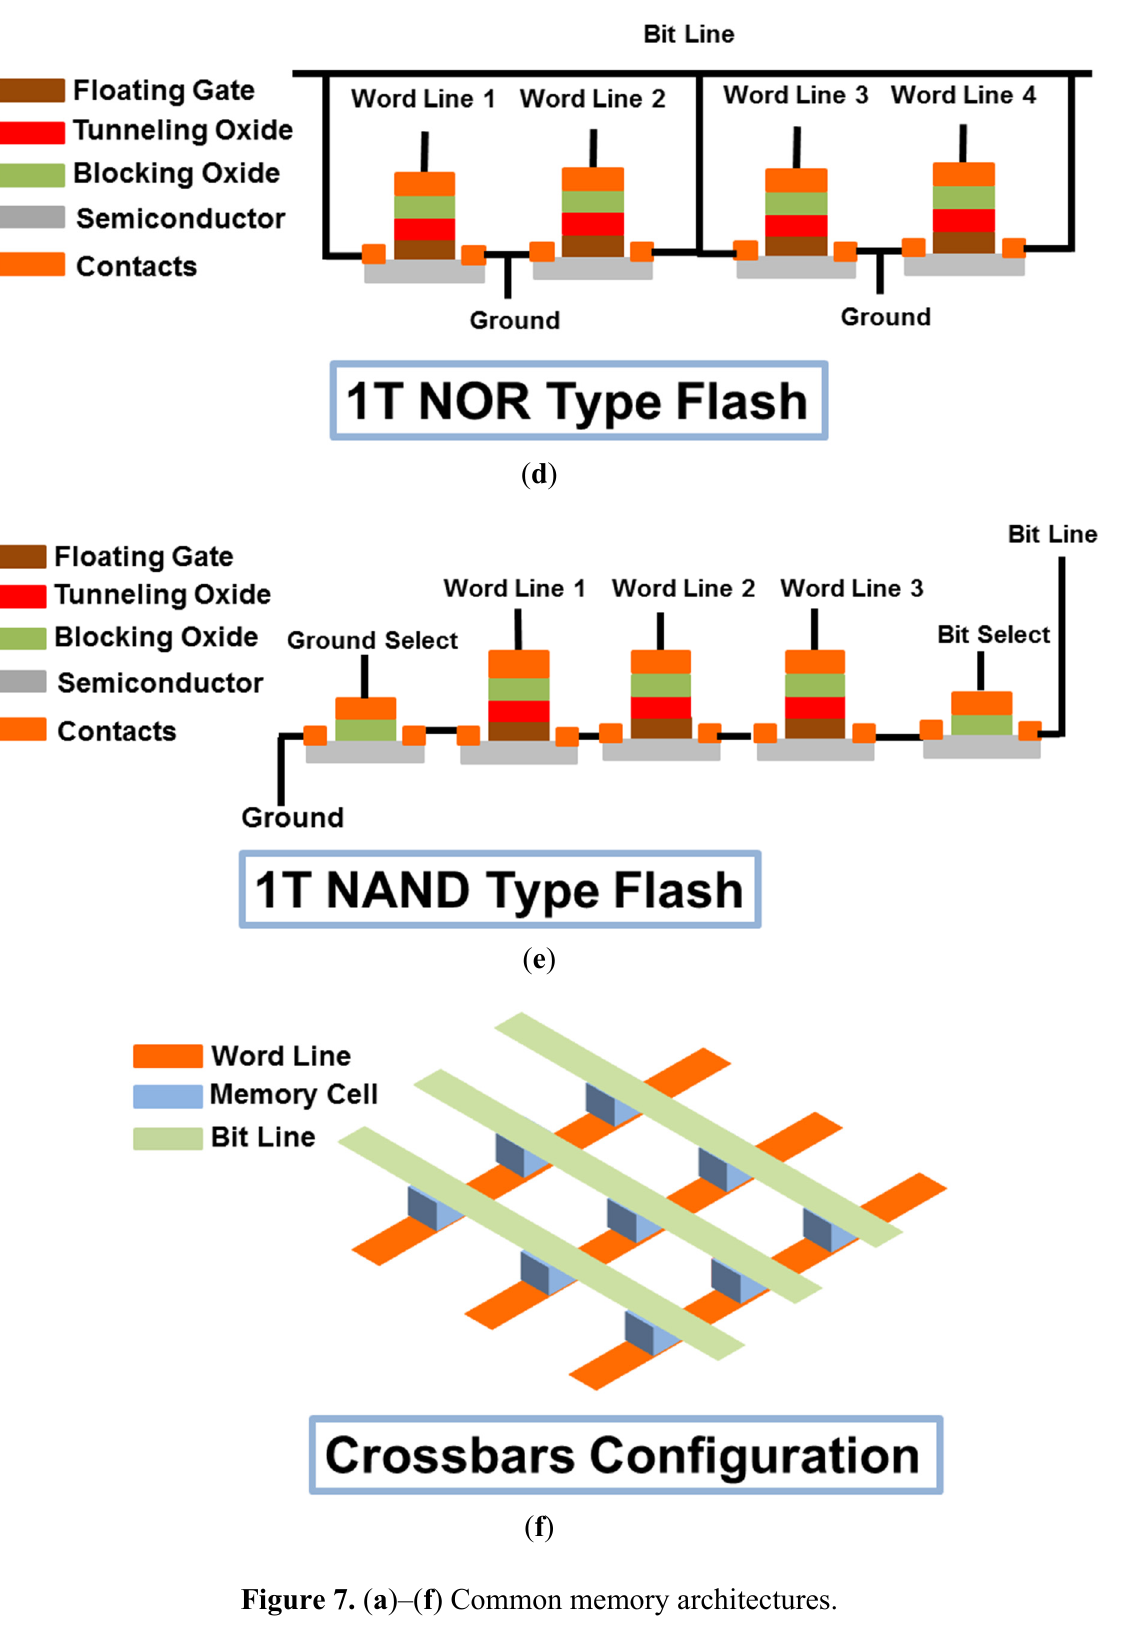
Figure 7. ( a )–( f ) Common memory